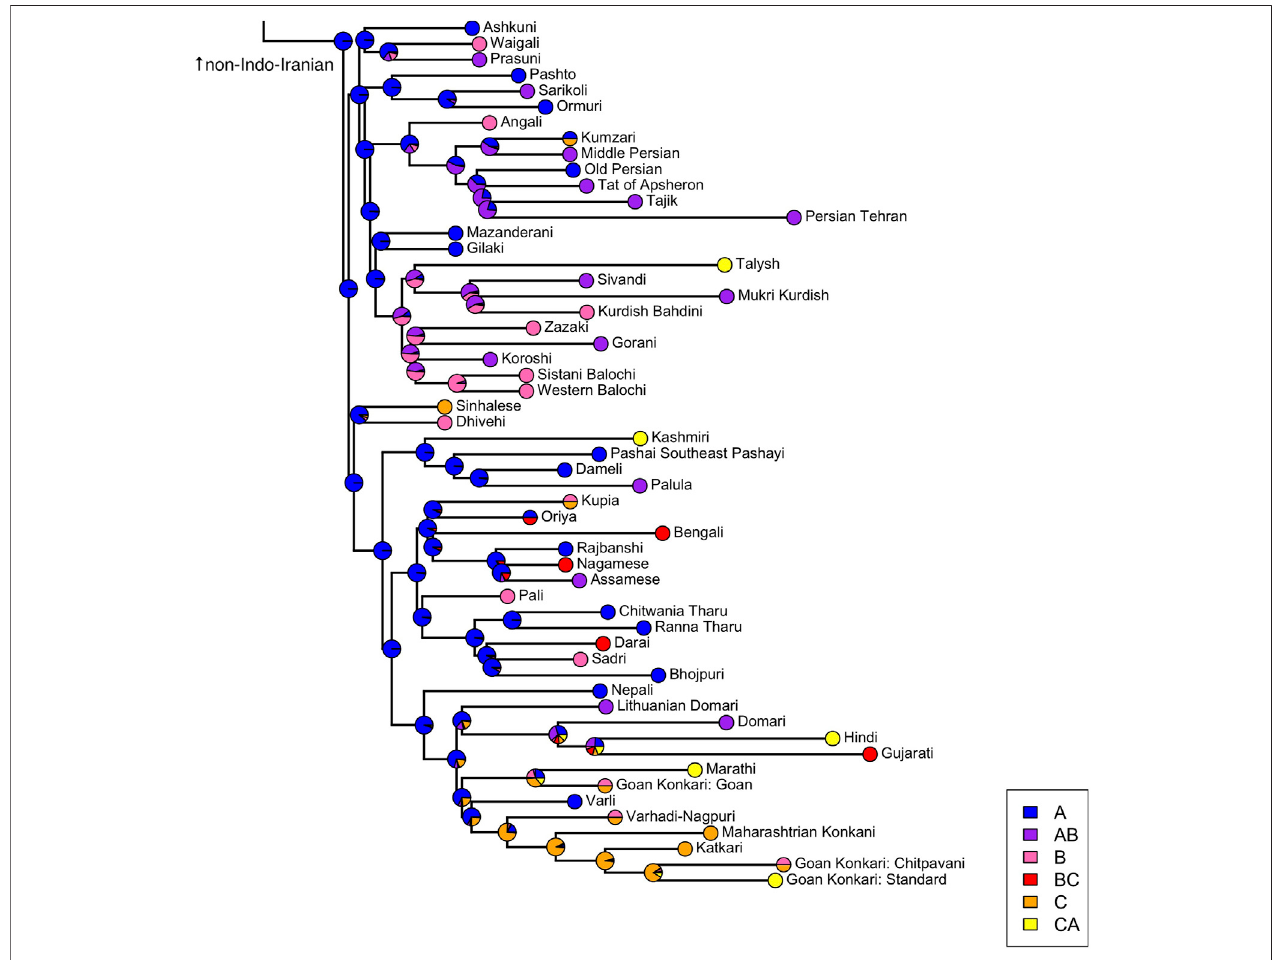
FIGURE 5 | An overview of negative existential construction types in Indo-Iranian languages, overlaid on a modi fi ed Indo-European Glottolog tree (Hammarström et al., 2014; Dediu 2018).